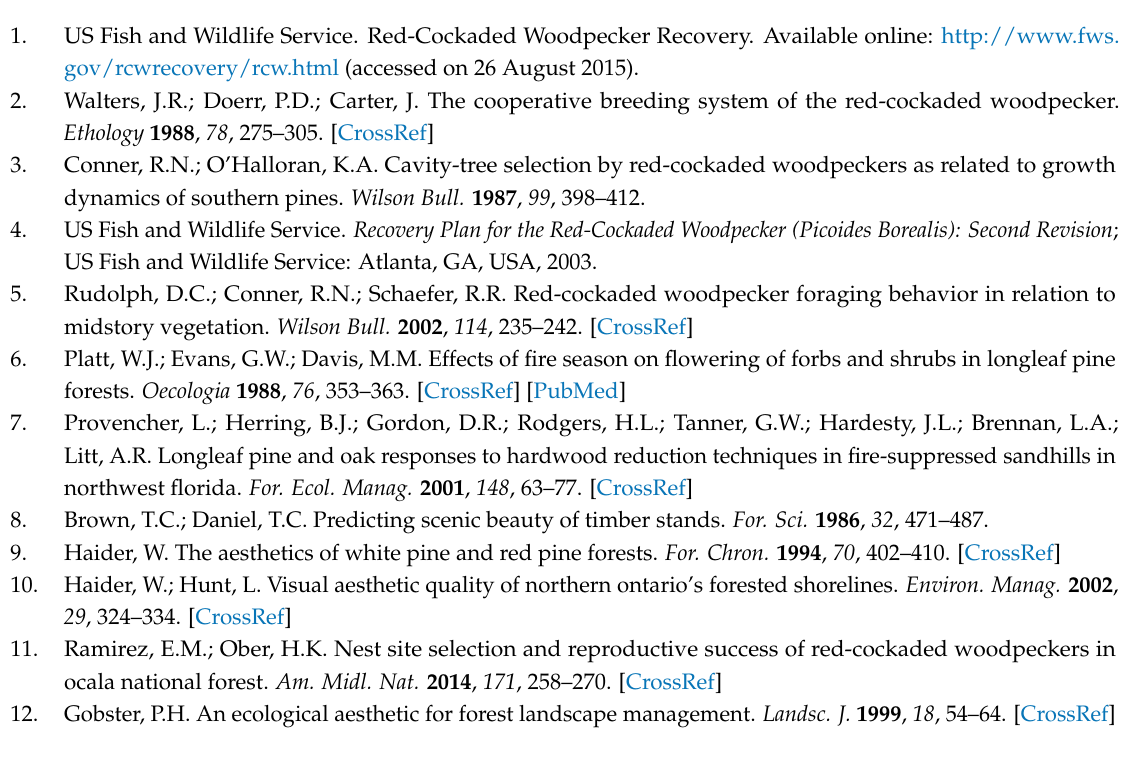
Figure S1: Photographic images used for panel selection of good and poor-quality RCW habitat in Ocala National Forest,